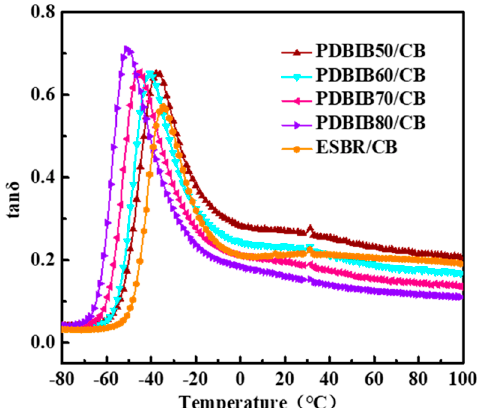
Figure 11. Temperature dependence of loss tangent (tan δ ) for PDBIB / CB and ESBR / CB nanocomposites.